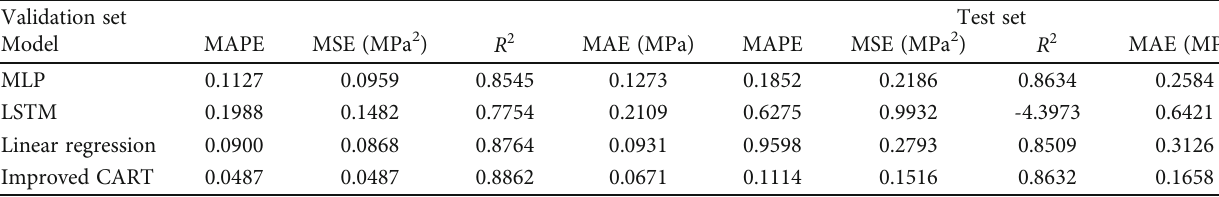
Table 3: Cross-validation results.